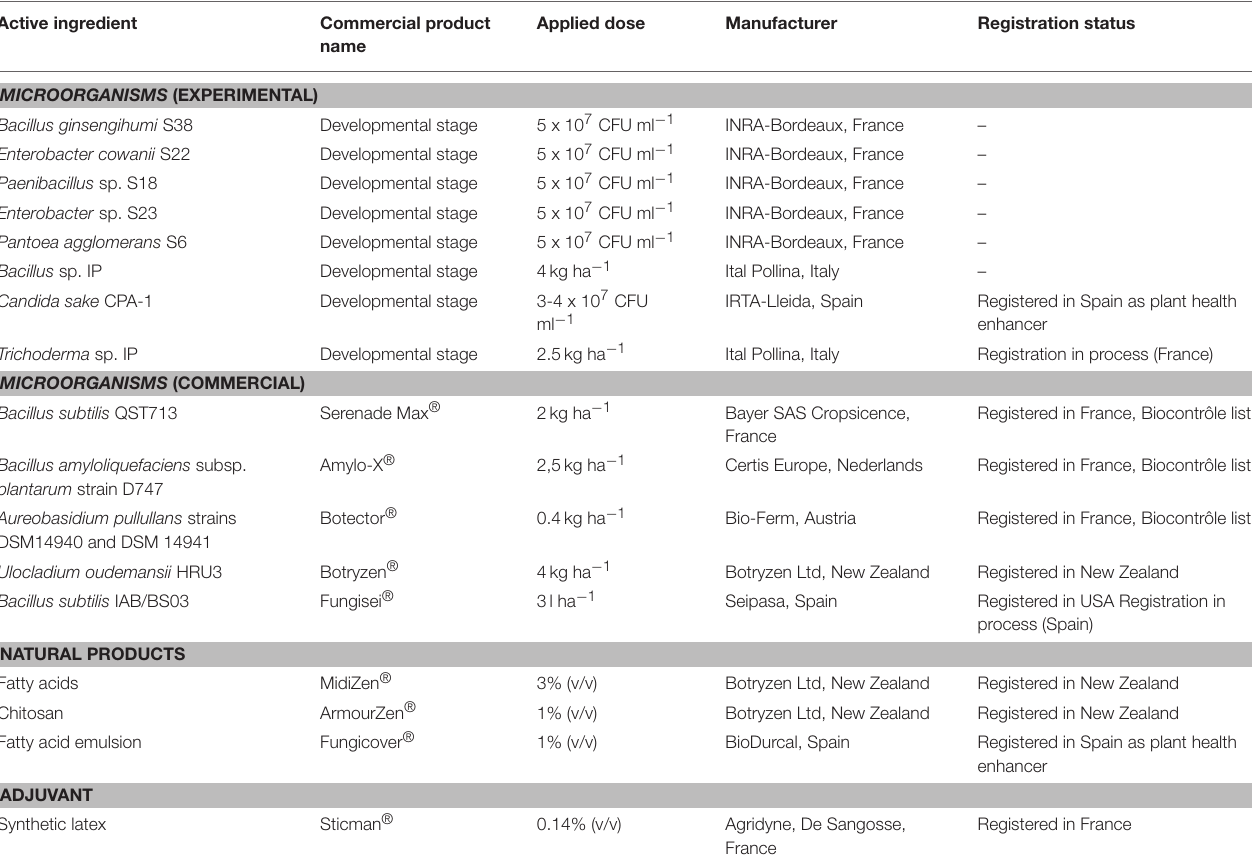
TABLE 1 | Biological control agents, adjuvants and natural products applied in the field